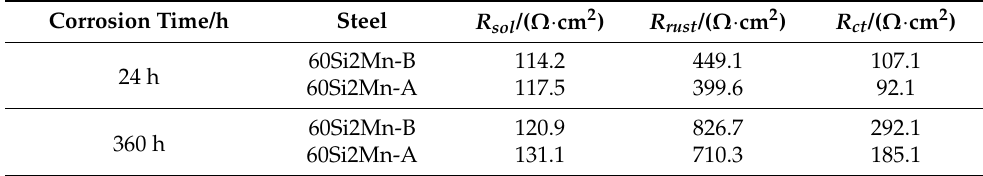
Table 5. Values of EIS fitting data of experimental steel with rust. Corrosion